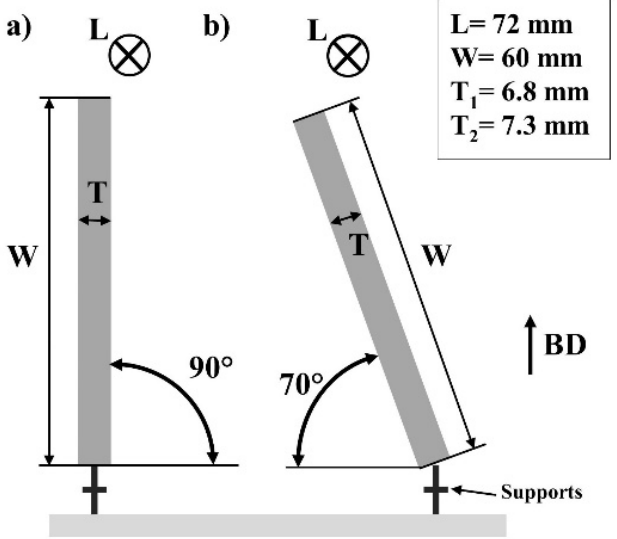
Figure 1. Sample geometry of the titanium inserts with W = width, L = length, T = thickness: ( a ) samples built parallel to the building direction; ( b ) samples built with a tilt angle of 70° with respect to the platform.